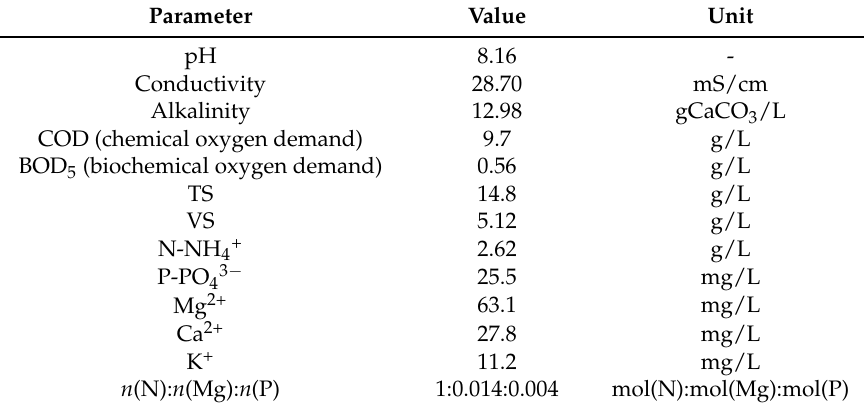
Table 1. Characteristics of landfill